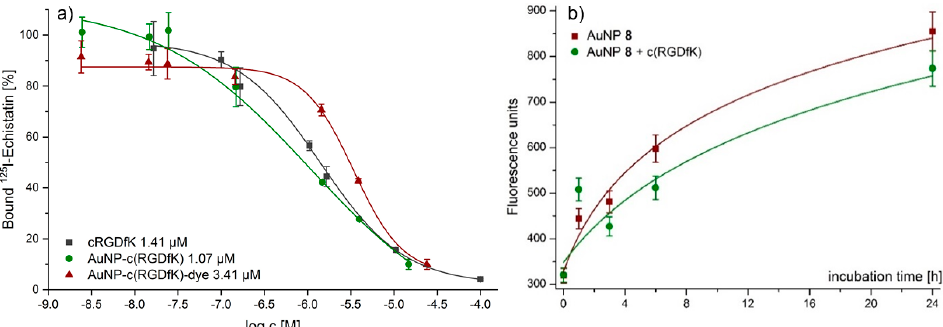
Figure 2. ( a ) Three representative IC 50 -curves from single competitive binding experiments. Shown is one curve with single IC 50 value out of three values from three different experiments. ( b ) Cell uptake studies of AuNPs 8 in A431 cells at different time points obtained without blocking (red) and with a 10-fold excess of c(RGDfK) (green).